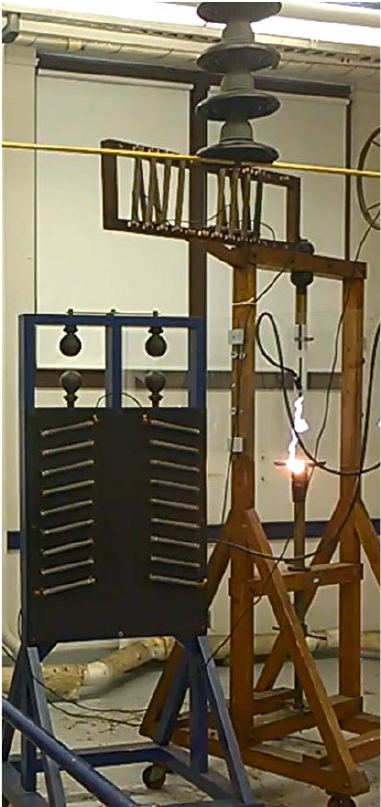
Figure 6. Static tridimensional spatial image of the spark discharge on sample A provided by a photo camera.